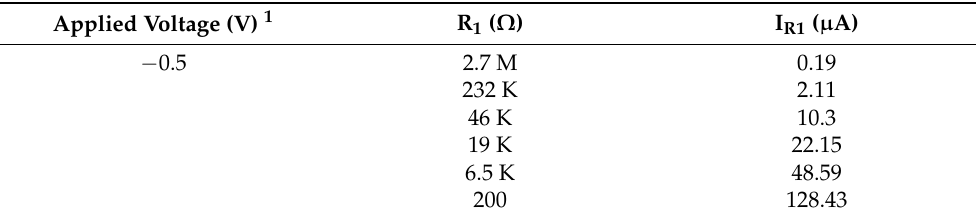
Table 2. Simulation results for applied voltage of − 0.5 V assuming R 2 = 305 Ω , R 4 = 3.2 k Ω